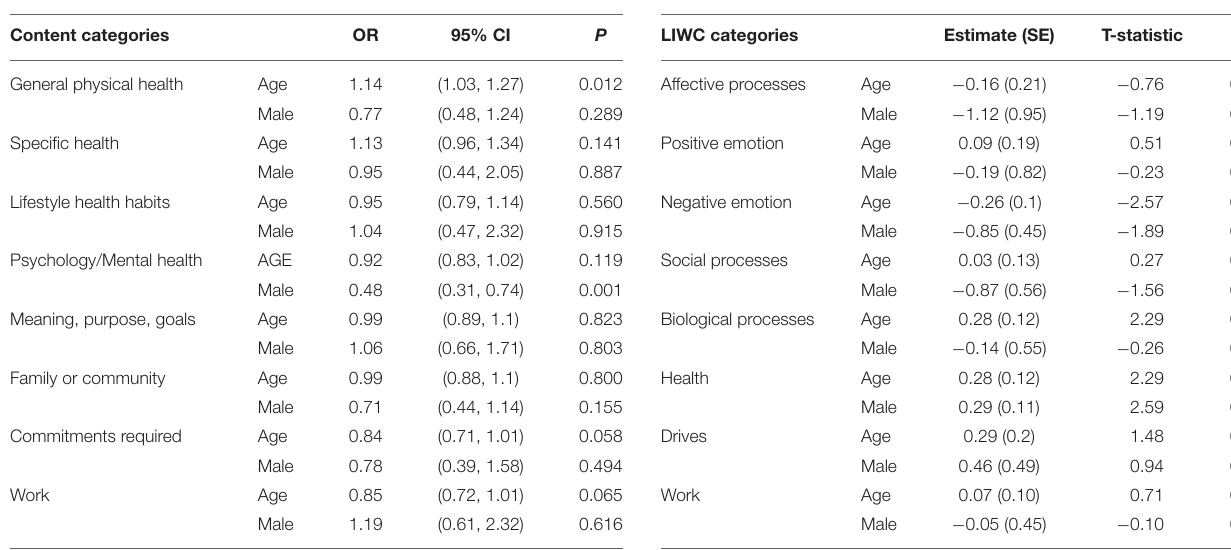
TABLE 2 | Estimated coefficients for age and gender associated with LIWC categories from a linear regression